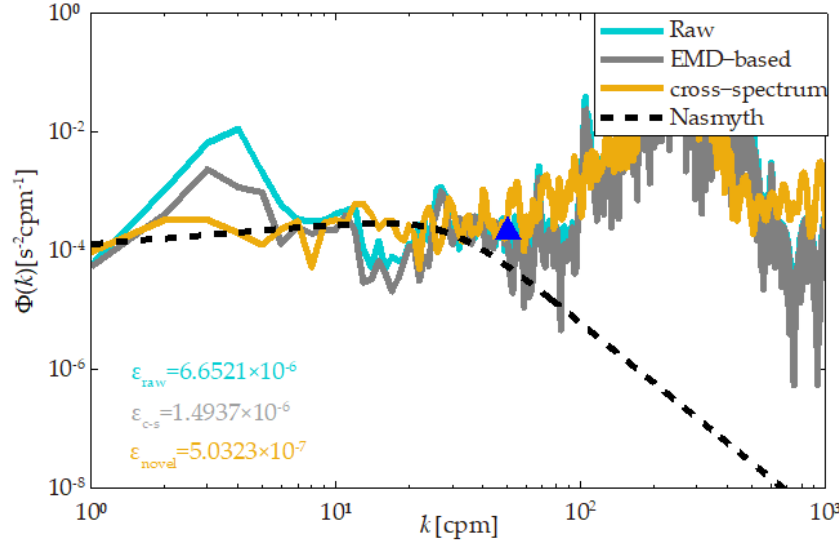
Figure 10. The comparison of denoising effectiveness in wavenumber domain.